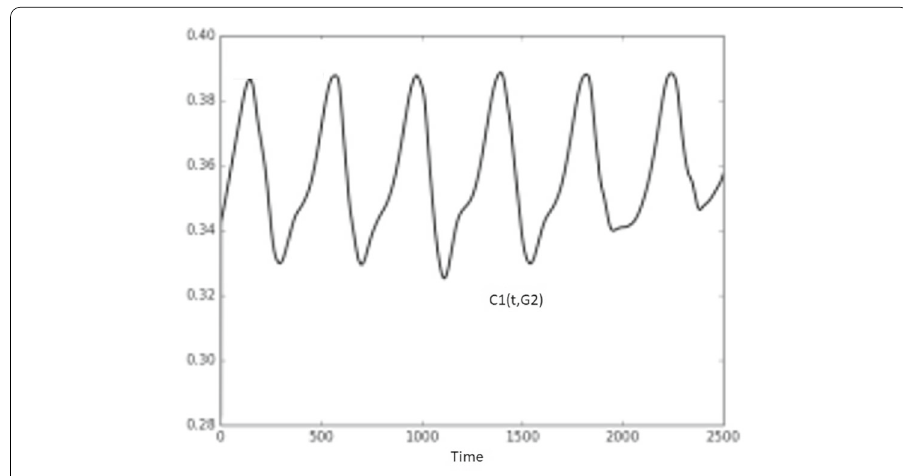
Fig. 32 The first temporal weight by the Galerkin projection upon (cid:9) : c 1 ( t,G 2 )